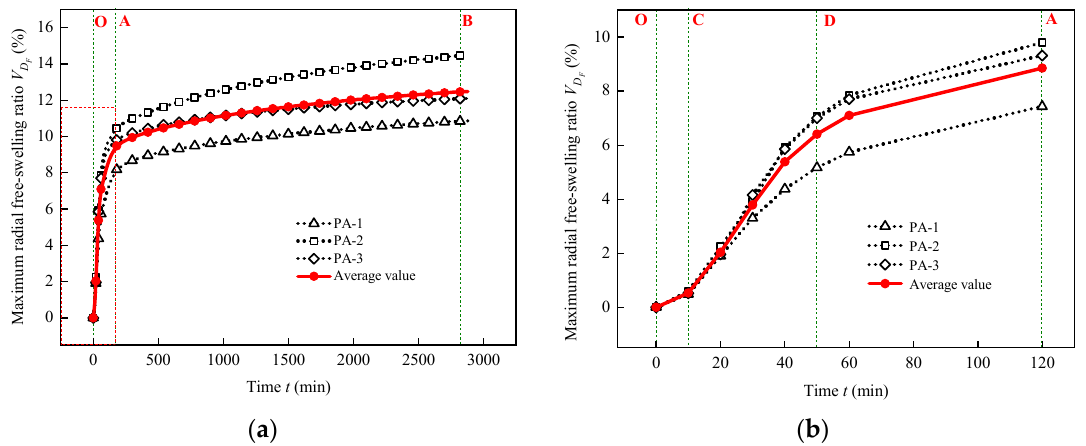
Figure 8. Maximum radial free ‐ swelling ratio. Relationship between the maximum radial free ‐ swelling ratio and time for ( a ) 2880 min and ( b ) during the first 120 min.